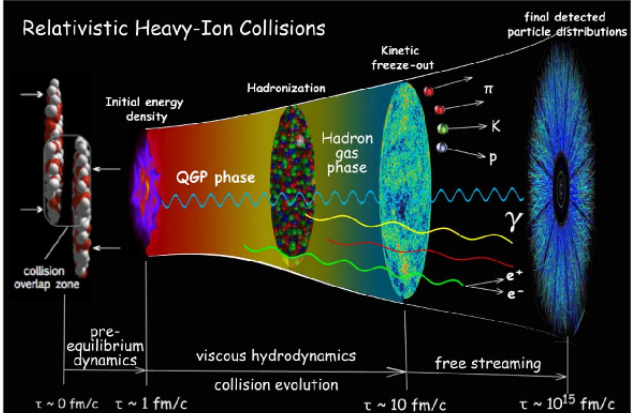
Figure 2. Illustration of the dynamical evolution of relativistic heavy-ion collisions and the QGP expansion [8].